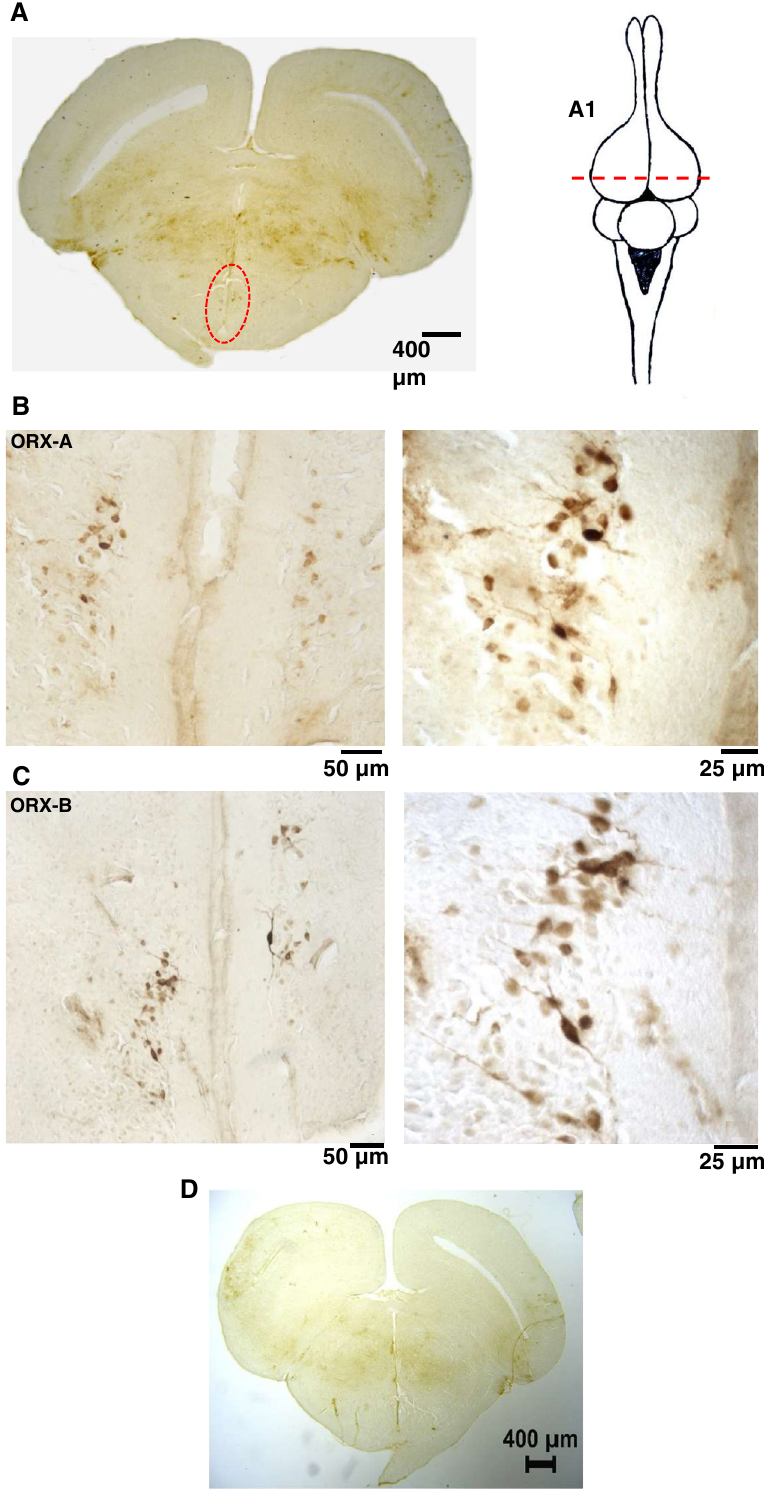
Figure 1. ORX labeling . Photomicrograph illustrating localization of the most prominent group of ORX- labeling and a scheme showing the level of the transection ( A ). The red circle indicates the localization of the cell bodies where were found the ORX neurons. A1: Schematic dorsal view of the lizard brain illustrating the rostro- caudal level where the section was taken. Photomicrographs illustrating ORX-A ( B ) and OXR-B labeling ( C ) in two different magnifications. Negative control ( D